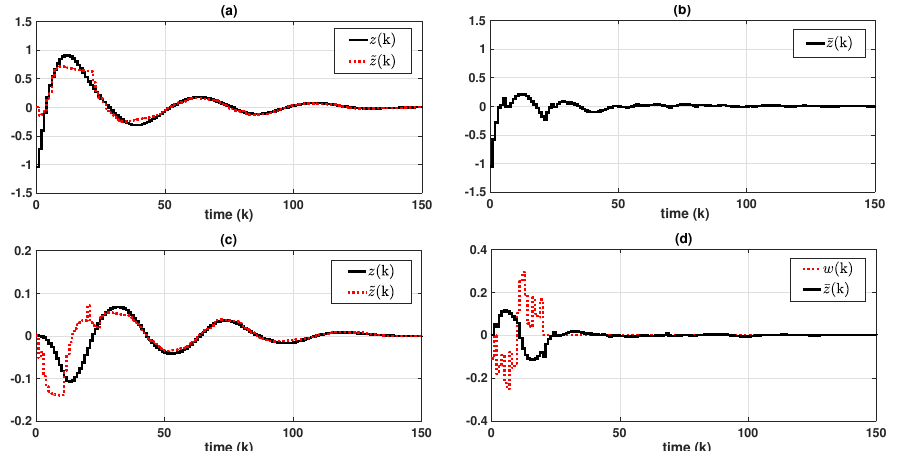
Figure 6. Filter response: ( a , b ) z ( k ) , ˜ z ( k ) , and ¯ z ( k ) for x ( 0 ) (cid:54) = 0 and w ( k ) ≡ 0; and ( c , d ) z ( k ) , ˜ z ( k ) , and ¯ z ( k ) for x ( 0 ) ≡ 0 and w ( k ) (cid:54) =